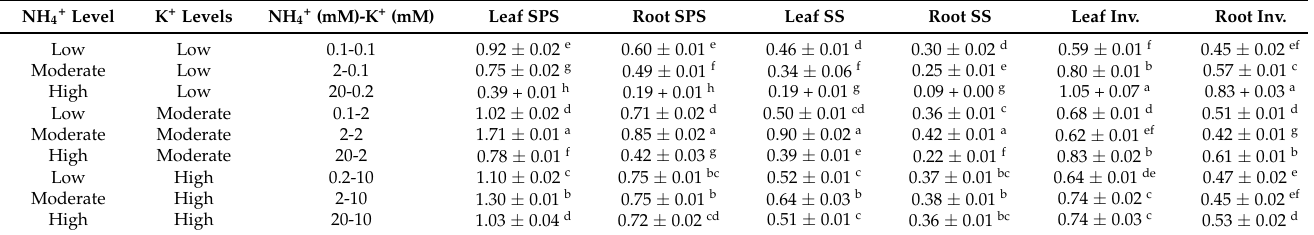
Table 7. The activities of sucrose phosphatase synthase (SPS), sucrose synthase (SS), and acid invertase (Inv.) in leaves, stems, and roots subjected to different NH 4+ and K + concentrations.